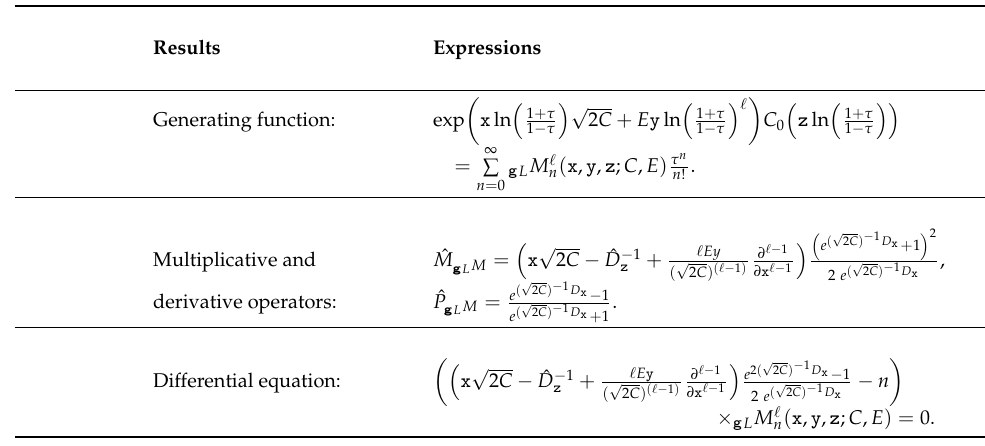
Table 8. Results for the EGHLMLMaP g L M (cid:96) n , ν ( x , y , z ; C , E ; η ) .